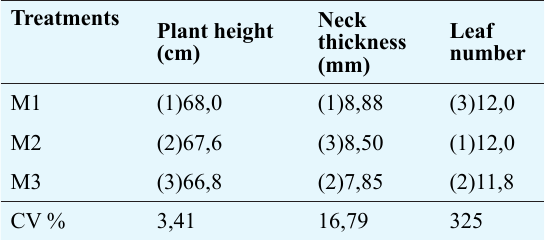
Figure 3. Effect of fertilisation method on garlic bulb size (mm) in cv. ‘Arequipeño-14’. All the values are means ± SE (n = 10). Table 4 Effect of fertilisation methods on the garlic vegetative growth in cv